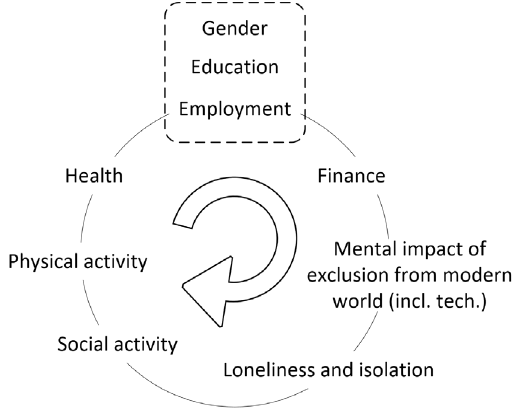
Figure 1. Cycle of Factors influencing Technology Use by the